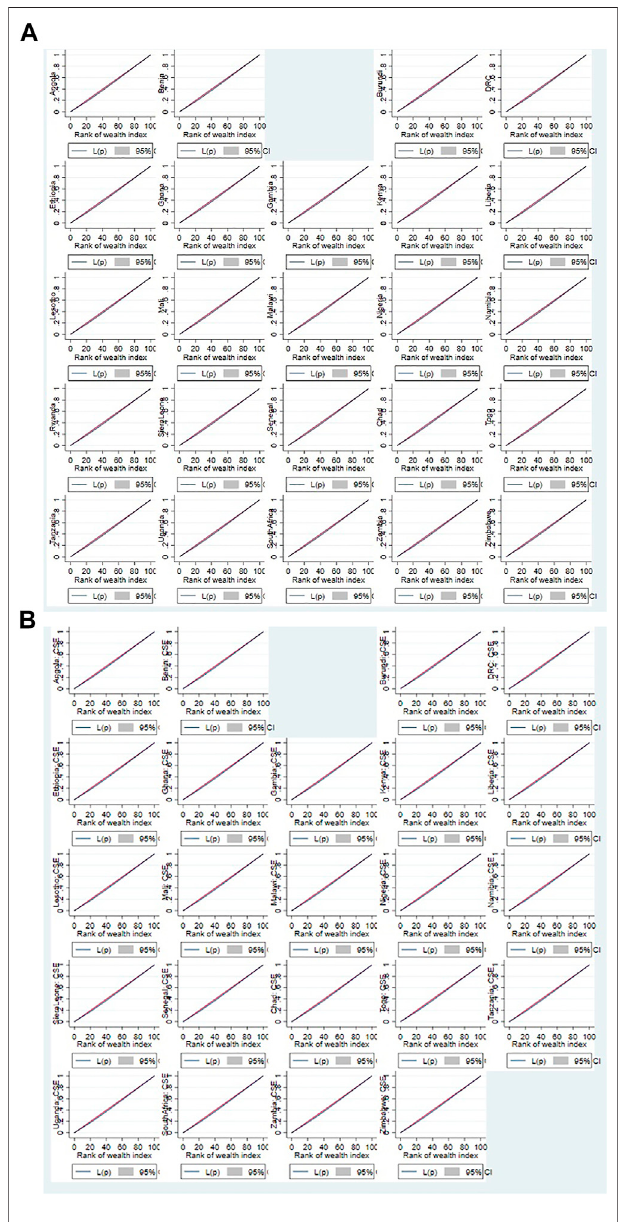
FIGURE 2 | (A) Relative concentration index in school enrolment among children aged 6 – 11 years. (B) Relative concentration index in school enrolment among children aged 12 – 17